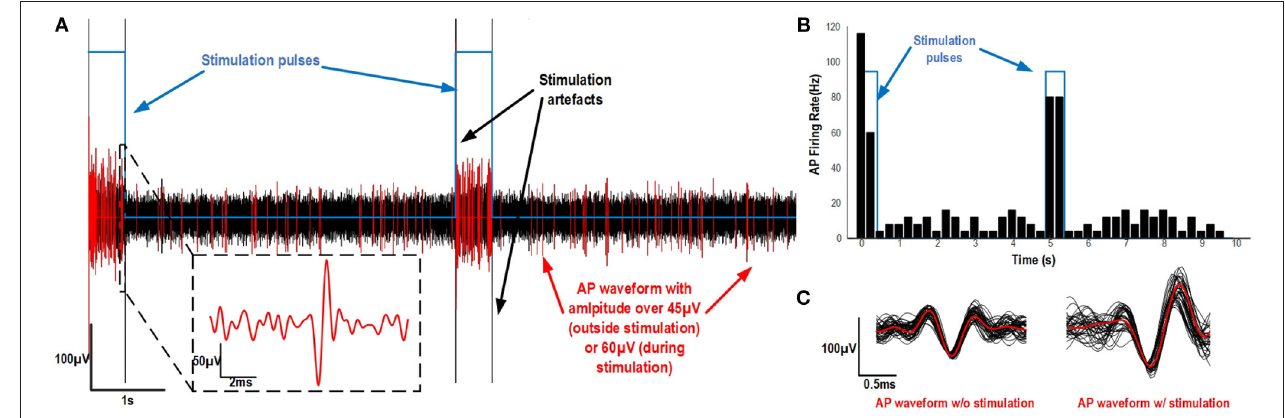
FIGURE 11 | (A) Recorded signal from one electrode of the optrode implanted in the Thy1::ChR2-EYFP transgenic mouse. Five hundred milliseconds of stimulation pulses were applied with a 4.5 s delay between each pulse. The simulation pattern is shown in blue, the recording in black and the detected AP waveforms in red. A zoom on an action potential of about 200 µ V is added to better visualize the activity present during the light pulses. (B) The AP firing rate at each moment of the experiment. (C) The clustered AP waveforms w/o stimulation and during the stimulation